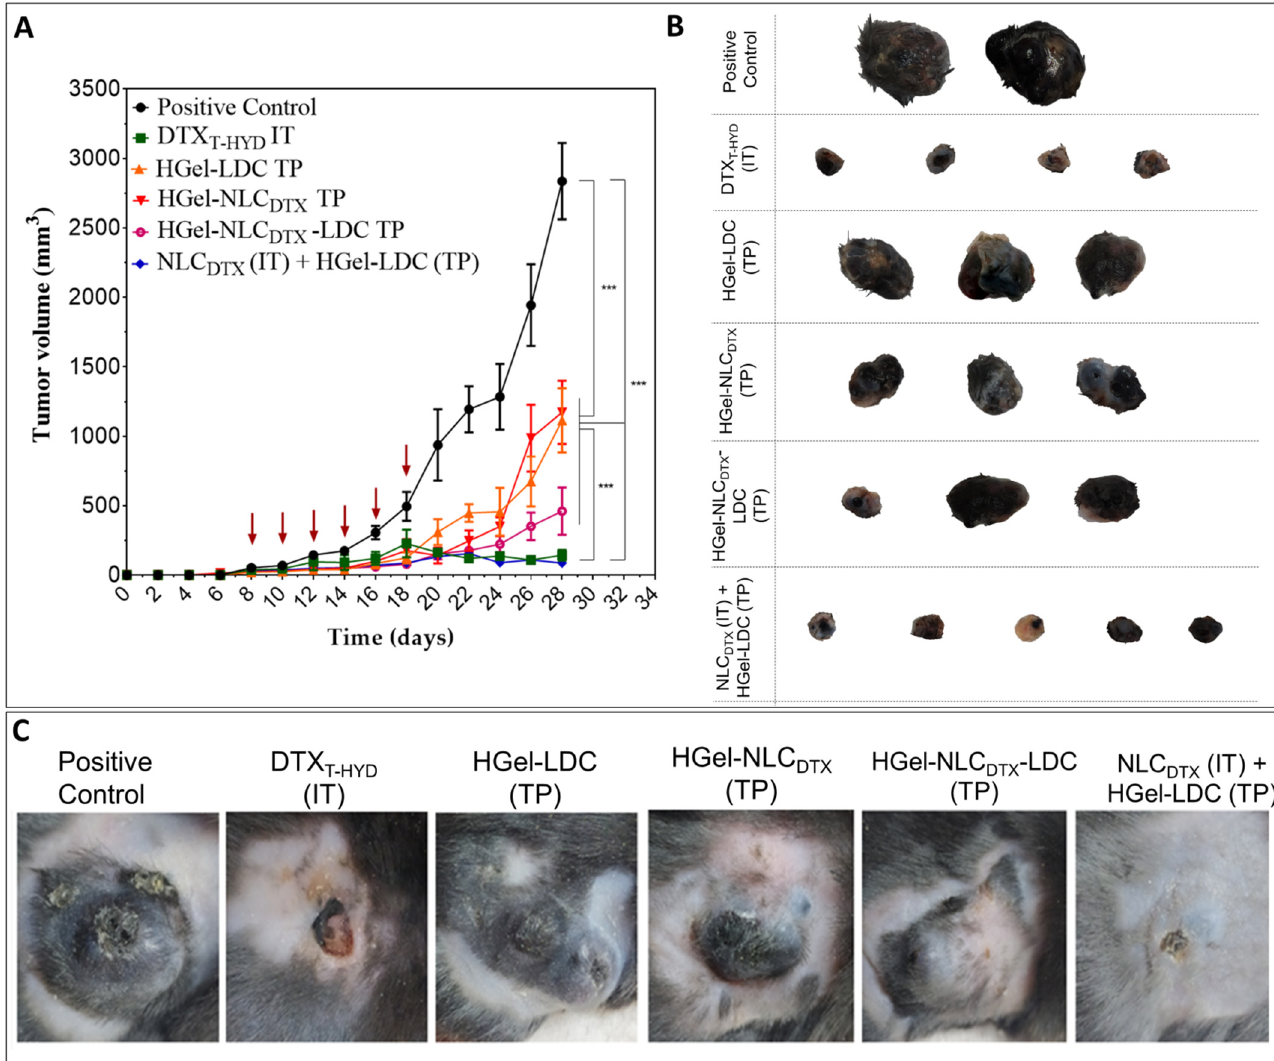
Figure 4. Antitumoral effect of saline (positive control), commercial Docetaxel (DTX T-HYD IT), HGel-LDC TP, HGel-NLC DTX TP, HGel-NLC DTX -LDC TP and NLC DTX IT + HGel-LDC TP on B16-F10 tumor-bearing C57BL/6J mice. ( A ) Variation of tumor volume as a function of time after treatment (started at day 8th and subsequently applied on the 10th, 12th, 14th, 16th and 18th day, as indicated by the red arrows). ( B ) Photographs of tumors from each treatment before euthanasia. ( C ) Representative images of tumors excised from each treatment group. TP = topical application; IT = intratumor application. Statistical analysis: Two-Way ANOVA post-hoc Bonferroni (*** p < 0.001). Data expressed as mean ± SD ( n = 5).